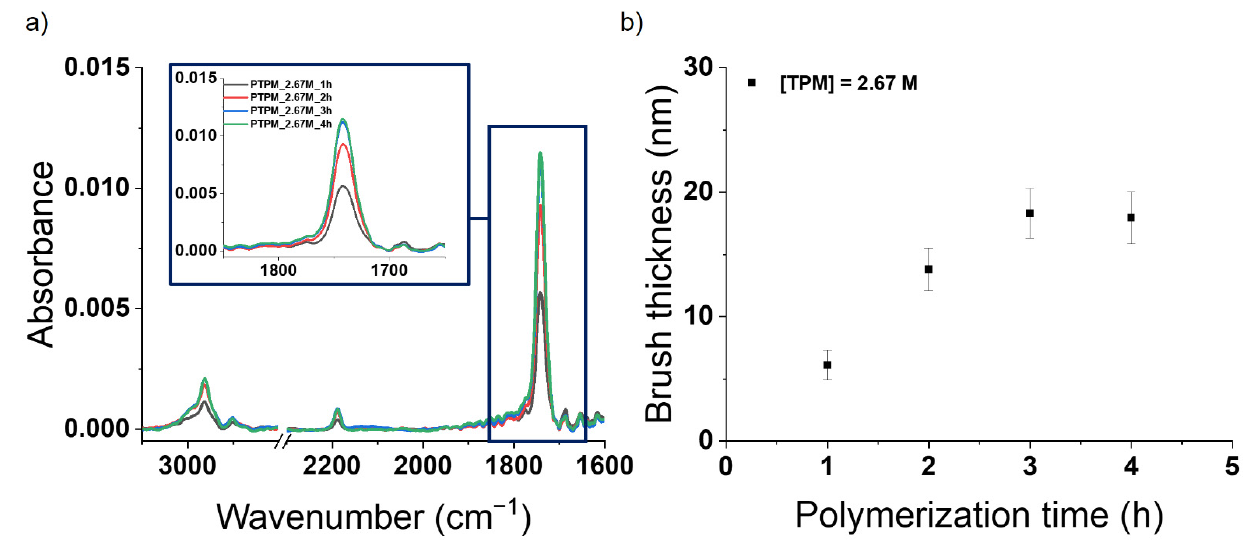
Figure 5. (a) FTIR spectra of PTPM brushes obtained after various times of metal-free SI-ATRP with the zoomed range corresponding to the absorbance of carbonyl group and ( b ) dependence of brush thickness (measured by AFM) vs. polymerization time.